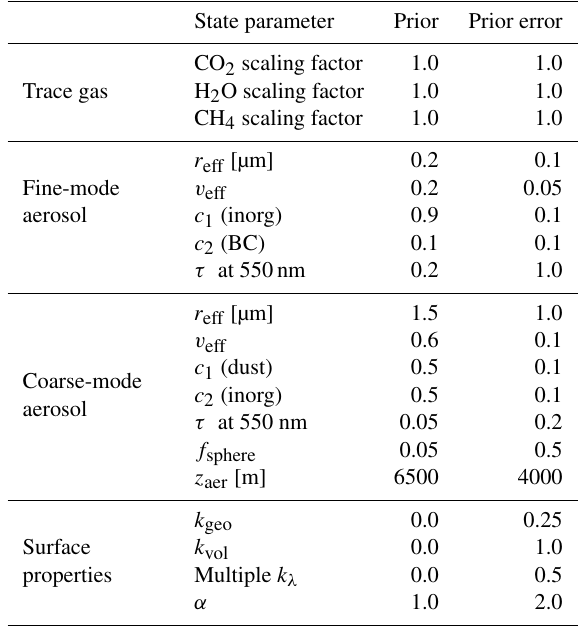
Table 2. State variables in the joint retrieval. Table 3. Aerosol properties in the ensemble. The numbers in square brackets specify the interval from which a random value is drawn, whereas a single number indicates a fixed